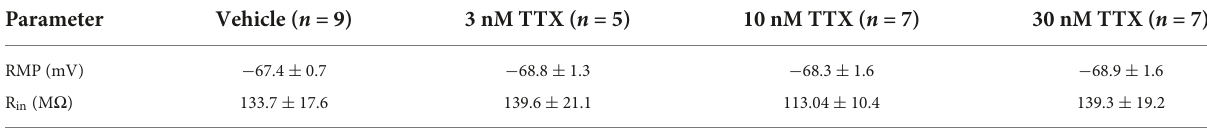
TABLE 1 Membrane characteristics of pyramidal neurons before (vehicle) and after application of various concentrations of TTX. Parameter